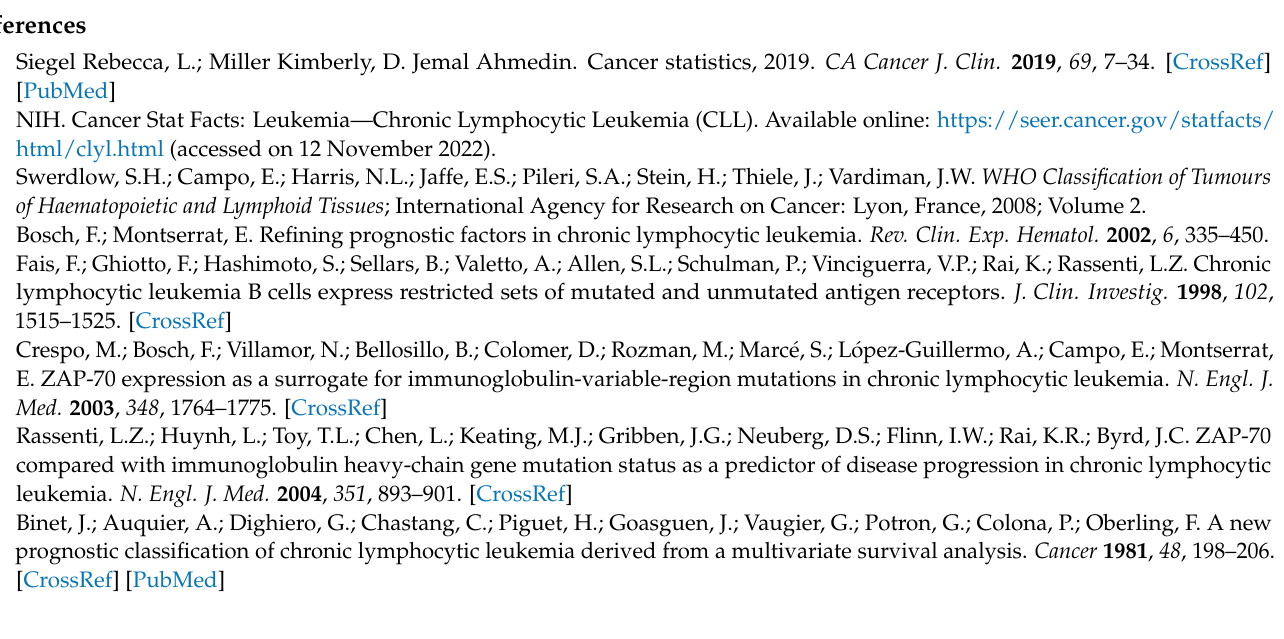
Biological Process; Table S3: WikiPathway Annotations; Table S4: Drug Sensitivity